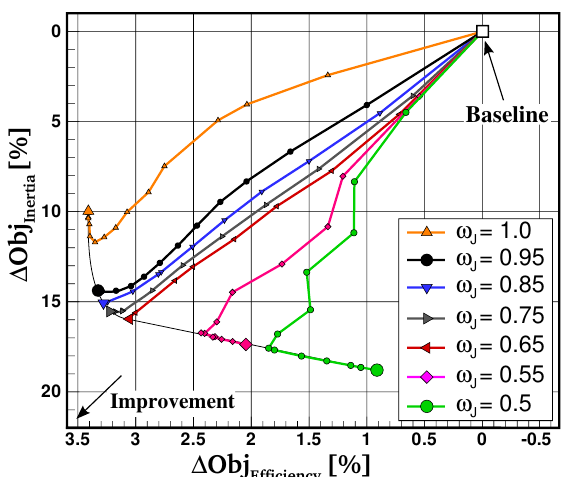
Figure 4. Two-dimensional objective space of the moment of inertia and total-to-static